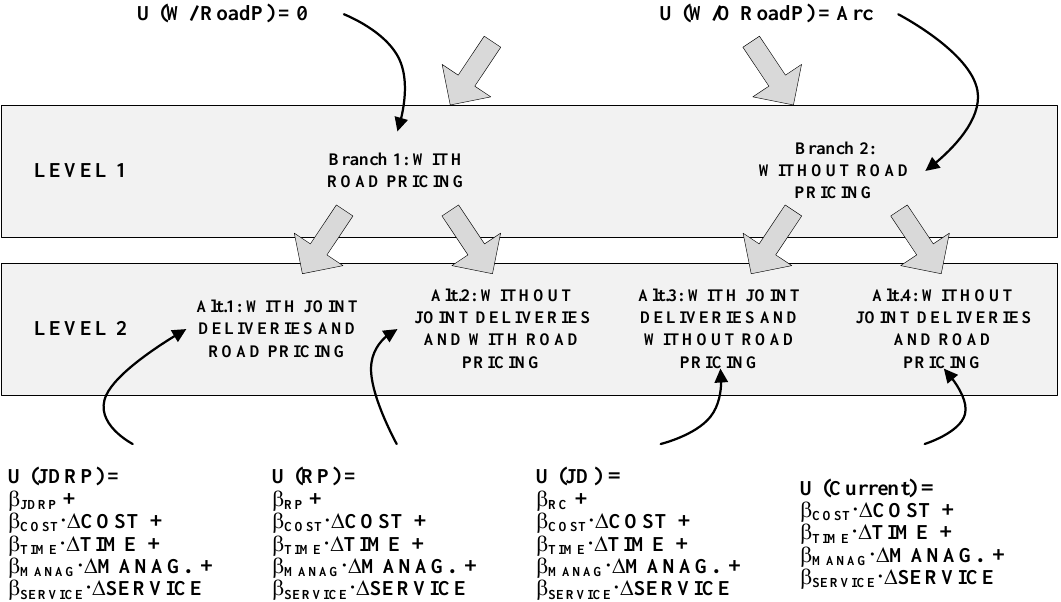
Figure 2. Structure of the hierarchical tree and of the resulting utility functions This hierarchical structure, together with the survey data, re sulted in the estimation of the β parameters of the utility functions, which correspond to the weights of the four objectives assigned to the carriers stakeholder group. The resulting parameter values are shown in Table 9, taking into account that the sign of the parameters is modified so that they all appear positive. Thus, instead of e.g. “Variation of delivery times”, with a negative weight of -0.23, the new objective is formulated as “Reduction of delivery times”, with a positive weight of 0.23. The output report provided by Limdep® is shown in Figure 3, whereas the non-hierarchical results (slightly worse than the nested case) are shown in Figure